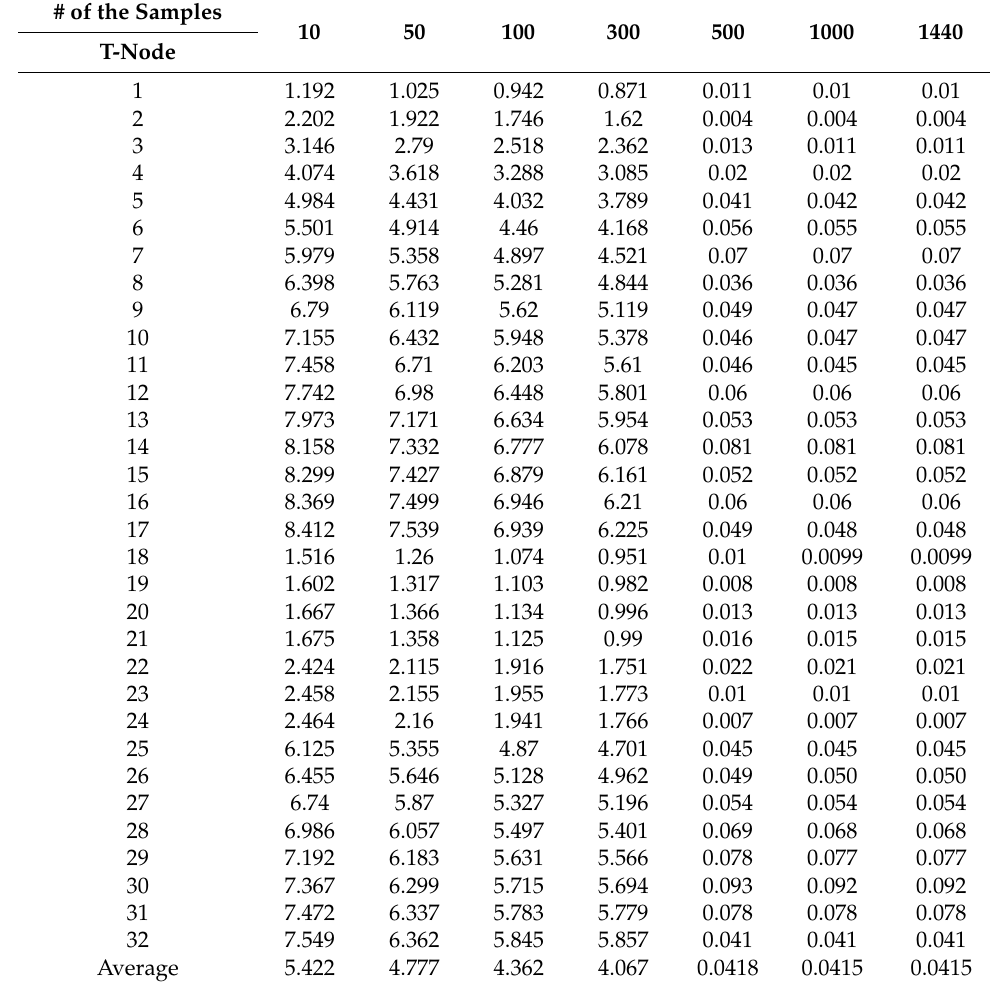
Table 3. T-node voltage prediction error rate (%) at 1.0 (p.u) slack node